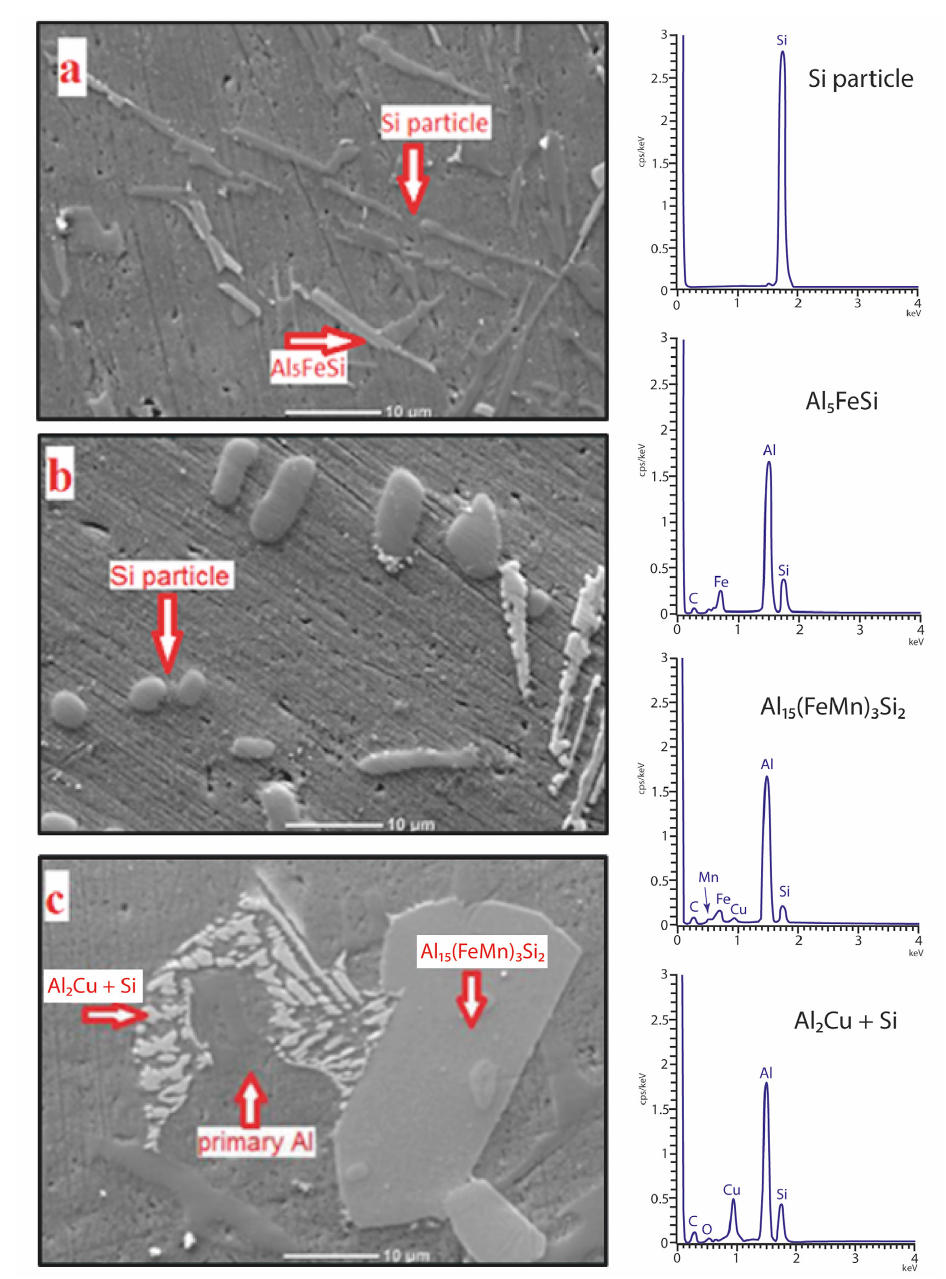
Figure 4. SEM images of the samples (a) as-cast sample (b) 500 o C/6h and ageing at 160 o C/6h (c) 540 o C/6h and ageing at 210 o C/2h. EDS spectra for each microconstituent is shown in the